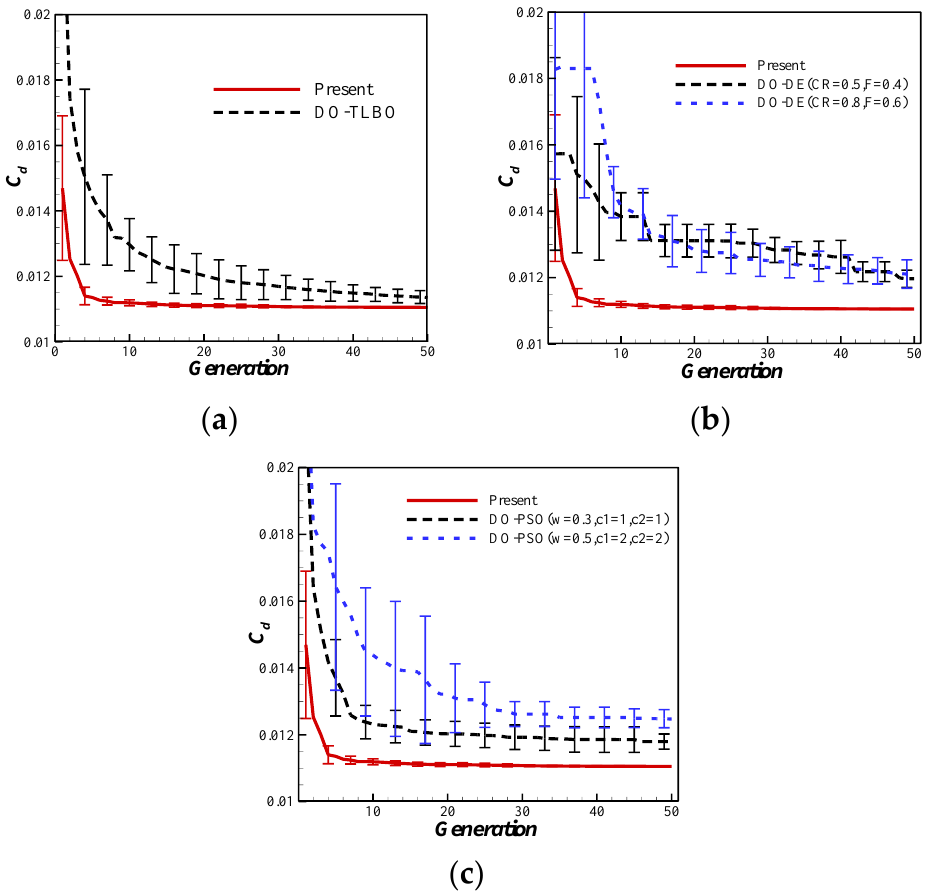
Figure 6. Error bar of the drag coefficient ( C d ) with the convergence process. ( a ) Present (DDSAO- TLBO) vs. DO-TLBO; ( b ) Present vs. DO-DE; ( c ) Present vs. DO-PSO.